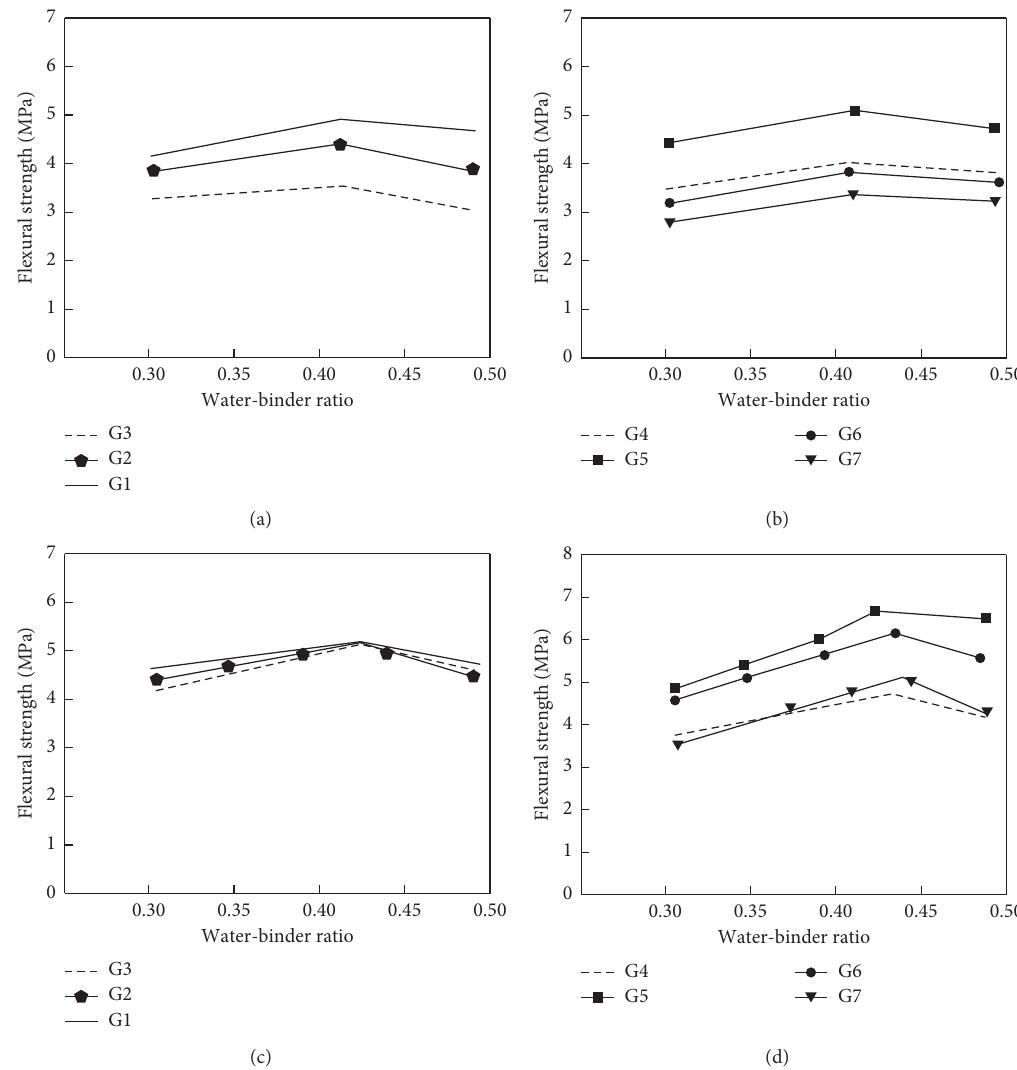
Figure 7: The variation of flexural strength of coal gangue-based polymer concrete with water-binder ratio. (a) Seven-day flexural strength (G1–G3). (b) Seven-days flexural strength (G4–G7). (c) 28-day flexural strength (G1–G3). (d) 28-day flexural strength